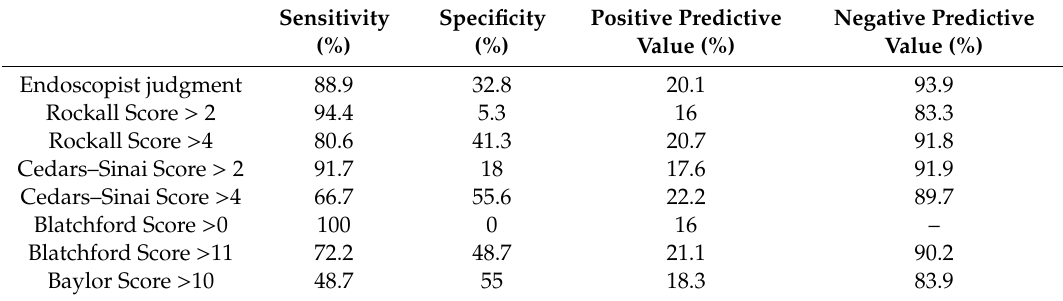
Table 5. Sensitivity, specificity and positive predictive values for rebleeding (endoscopic treatment group).